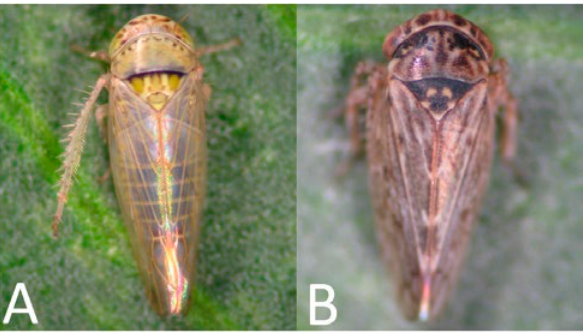
Figure 1. The two insect species used in transmission trials: A) Par- atanus exitiosus ; B) Bergallia valdiviana.